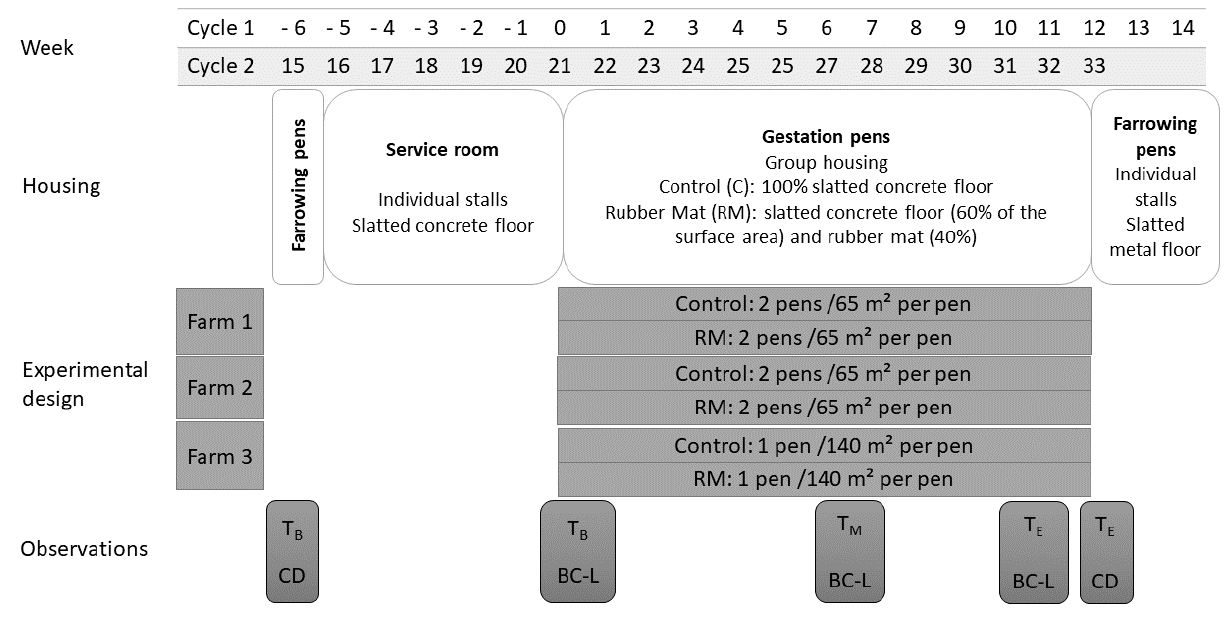
Figure 1. Experimental protocol .